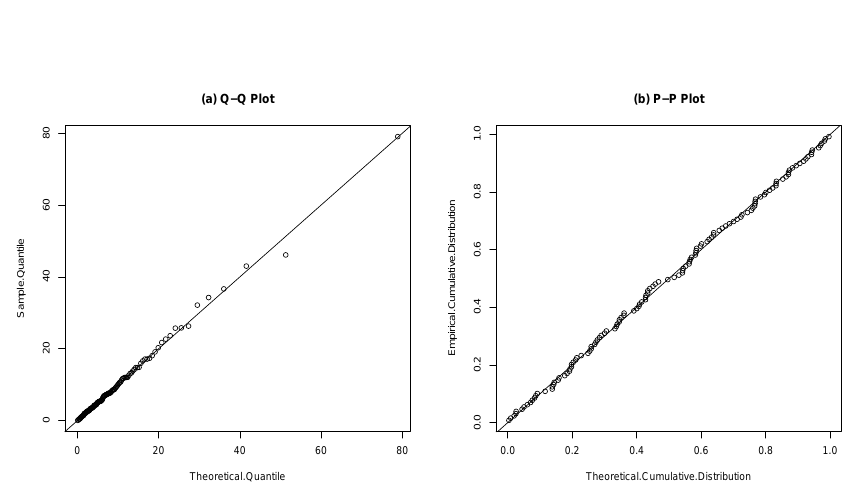
Figure 4 – P-P and Q-Q plots for the APTL distribution for data set 1.